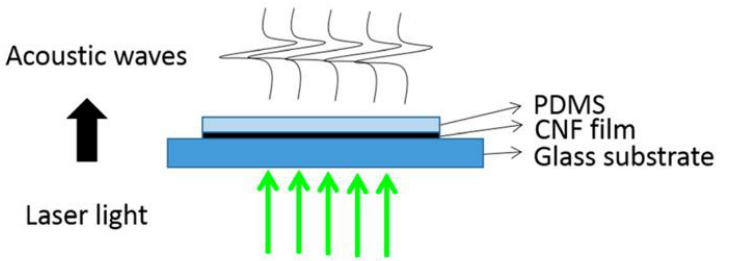
Figure 9. Organization of the carbon nanofibers and PDMS layers. Reproduced with permission from [123].